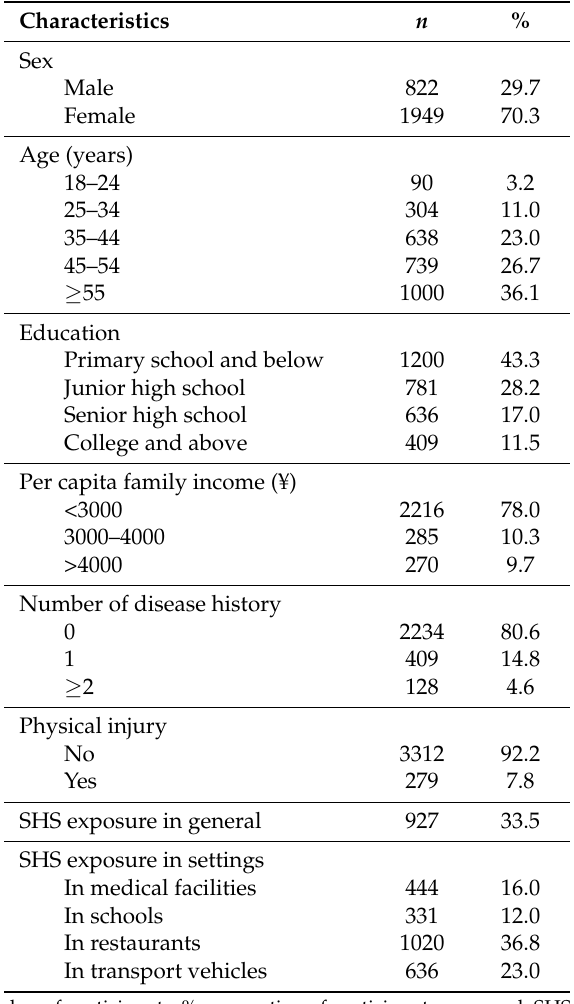
Table 1. Demographics characteristics of the non-smokers ( n =